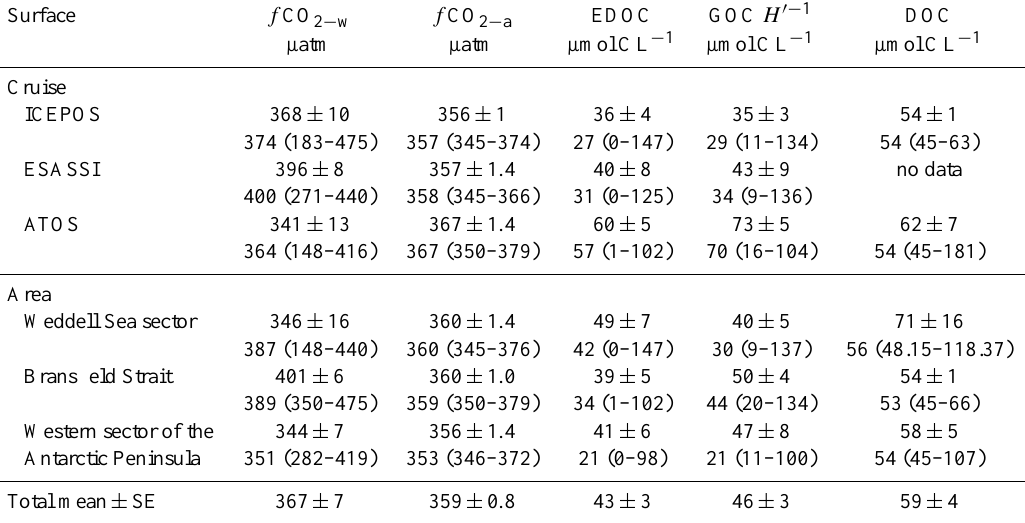
Table 2. Mean ± standard error (SE), median and ranges for CO 2 fugacity in water and air, EDOC, GOC H 0− 1 and DOC throughout the tracking of the three cruises ICEPOS in 2005, ESASSI in 2008 and ATOS-Antarctica in 2009. Data were grouped into cruises and basins. Note that means for the different areas come from all three cruises and that there are no DOC data for the ESASSI cruise.